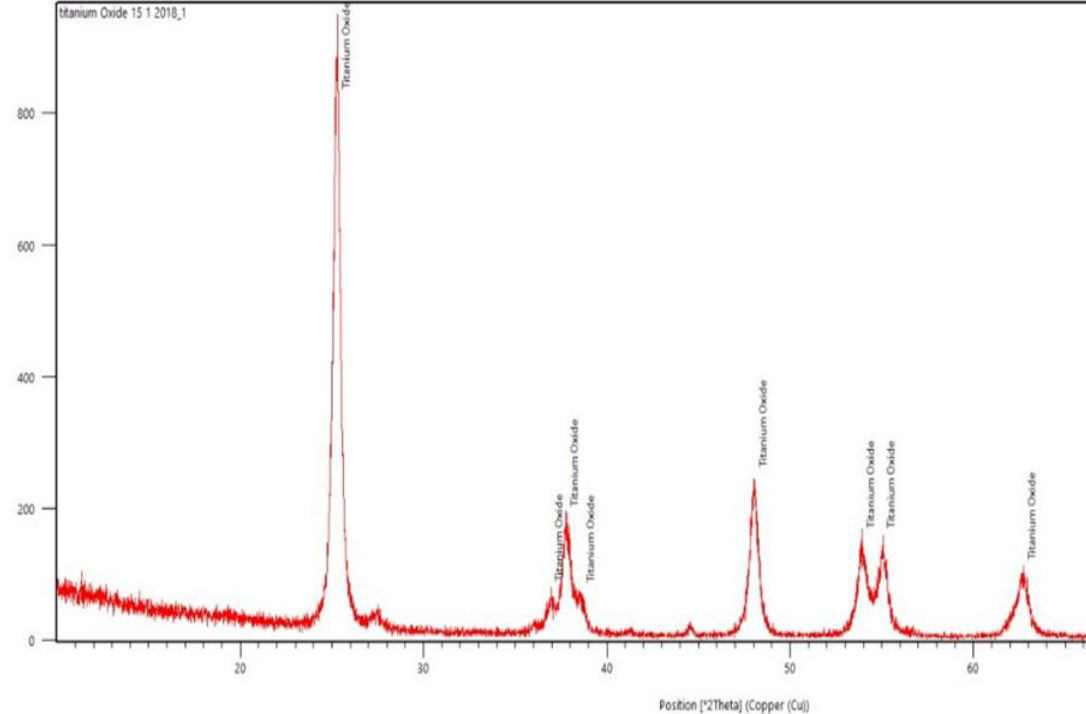
Figure 2 : XRD pattern for Titanium oxide